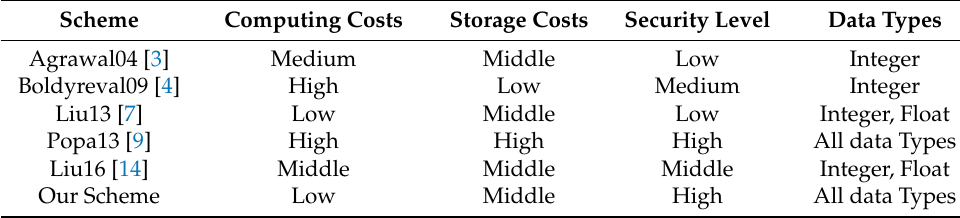
Table 4. The results for message